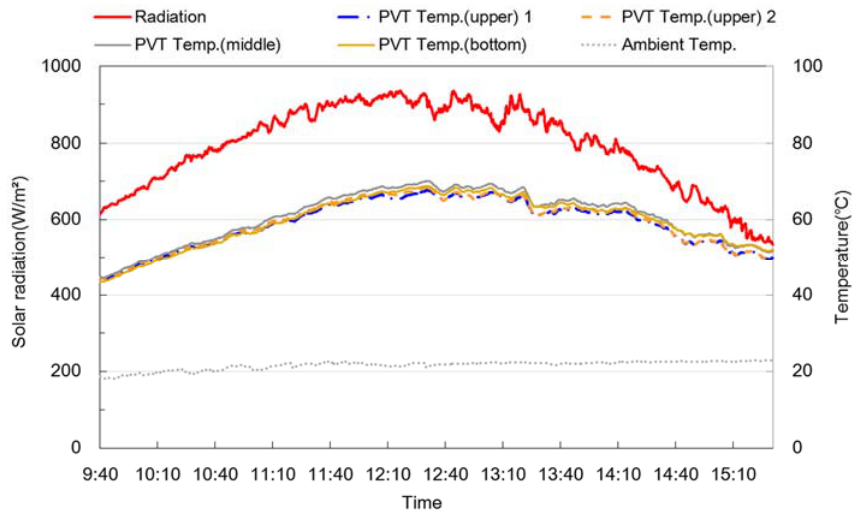
Figure 13. PV Temperatures of the PVT system with (upper) and without (bottom) the operation of a fan during the non ‐ heating season.